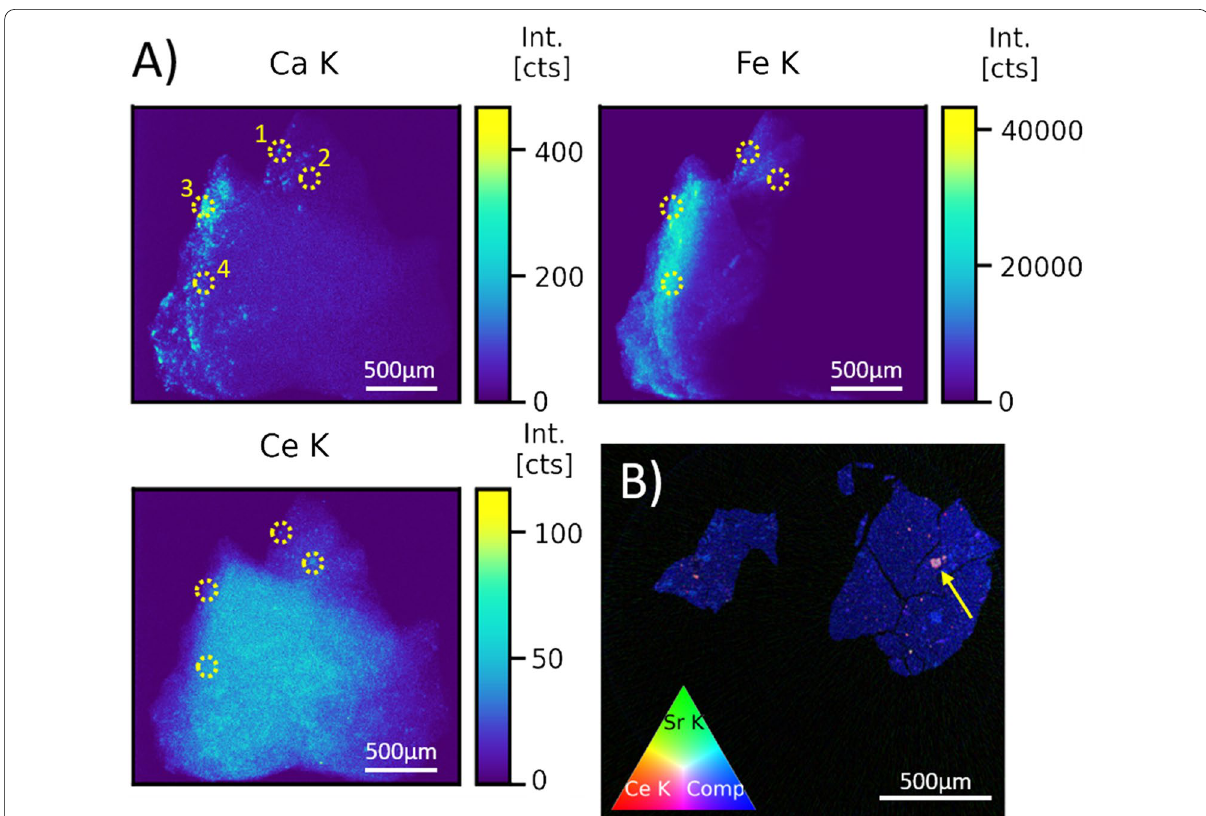
Fig. 2 XRF overview elemental distribution images (5 µm step size, 0.2 s/pt) for Hayabusa2 return sample A0055 ( A ) and XRF–CT cross‑sectional RGB image ( B ) presenting a virtual horizontal cut through point 2 displaying the Ce, Sr and Compton scatter distribution within the sample (5 µm 0.4° steps, 0.2 s/pt). Yellow marks and numbers indicate the points of interest that were further ×